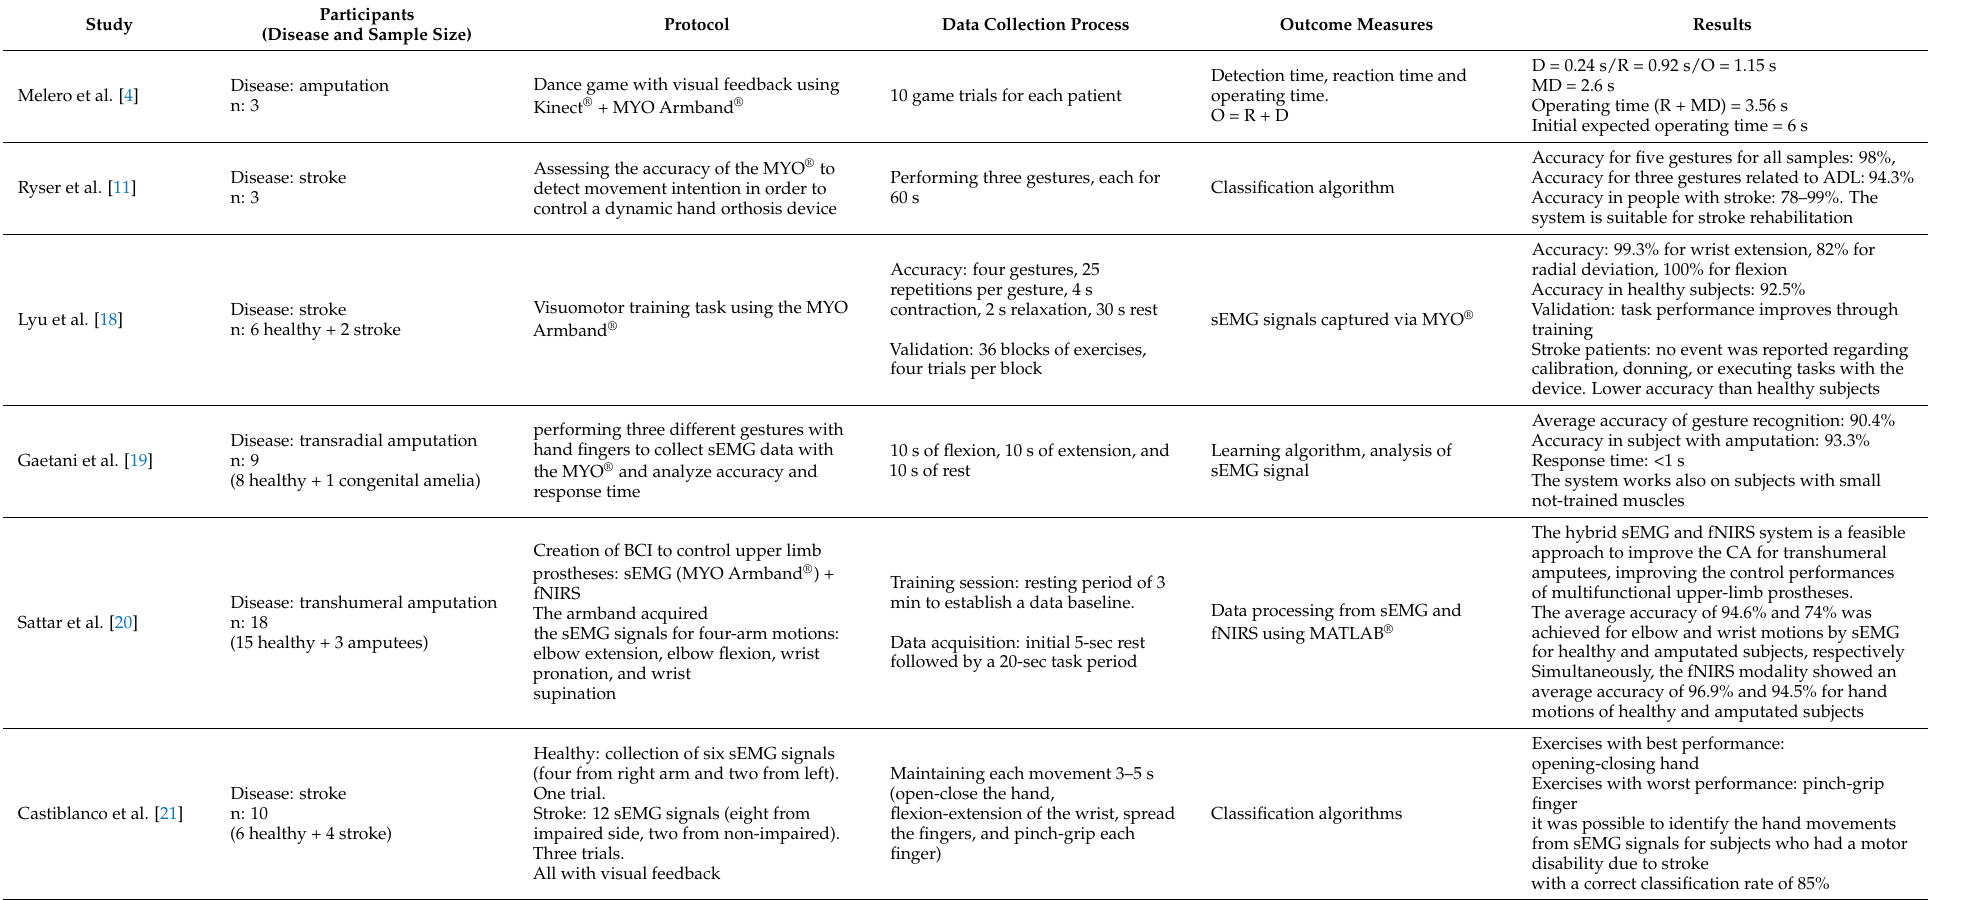
Table 2. Characteristics of the studies focused on the accuracy of the device as an assessment